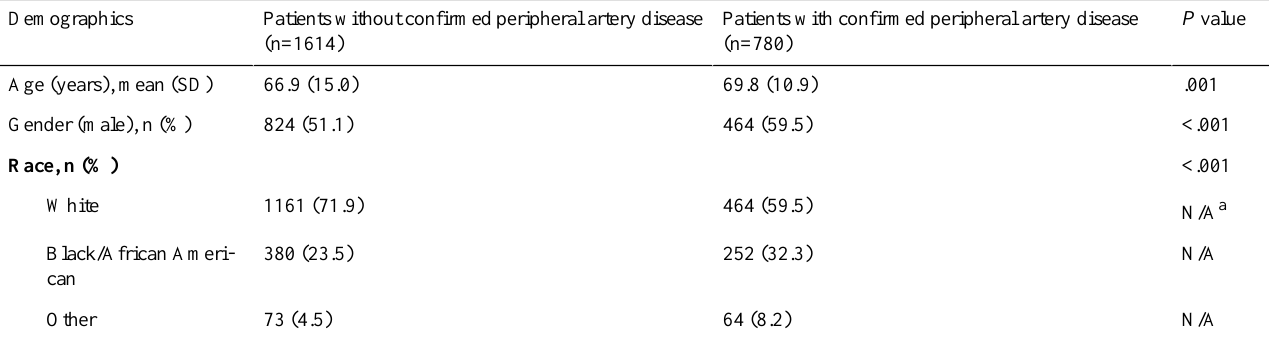
Table 1. Baseline characteristics of initially-adjudicated patients by confirmed peripheral artery disease